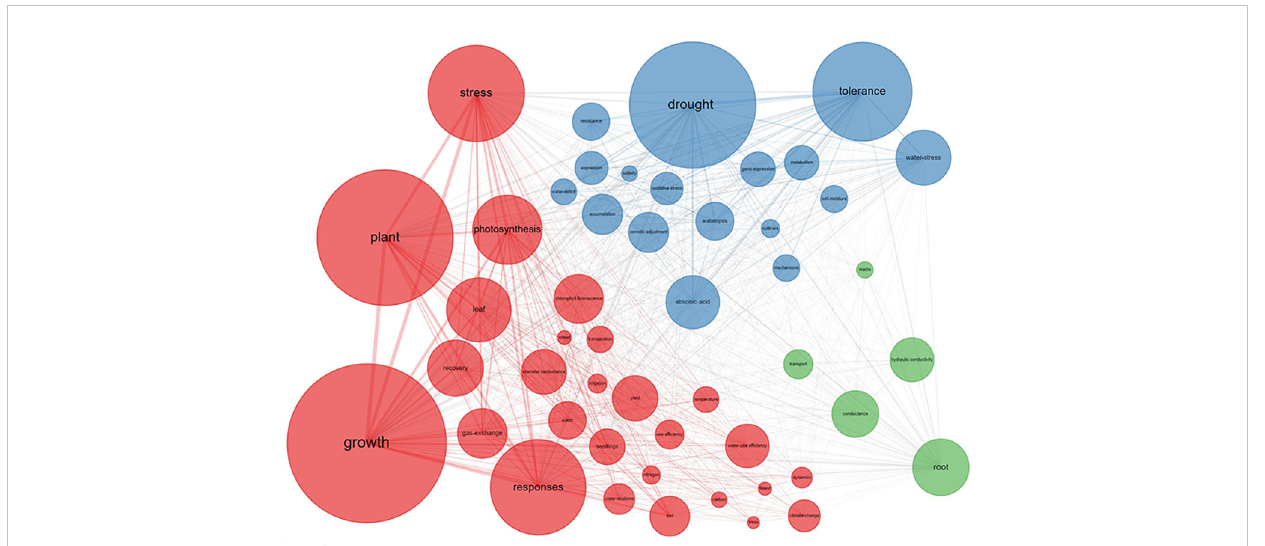
FIGURE 3 Co-occurrence Network of top 50 keywords. The size of the circle and the connecting lines represent the frequency and the relationship of the keywords, separately. The larger size the rectangular is, the higher the frequency. Similarly, the thicker the line is, the closer the relationship between keywords. Different colors represent different clusters, indicating that these keywords appear more frequently in the same publication. Red cluster, leaf parameters ’ response; blue cluster, molecular, and physiological responses; green cluster, root hydraulic and water transport